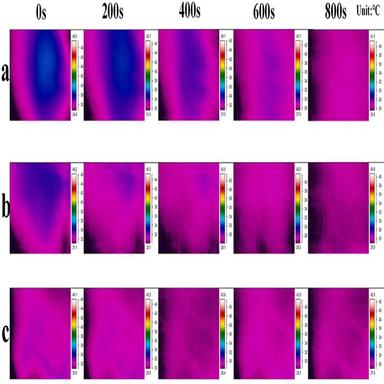
Infrared camera images of (a) Ref. EP, (b) MPCM/EP and (c) T-MPCM/EP during the cooling process.